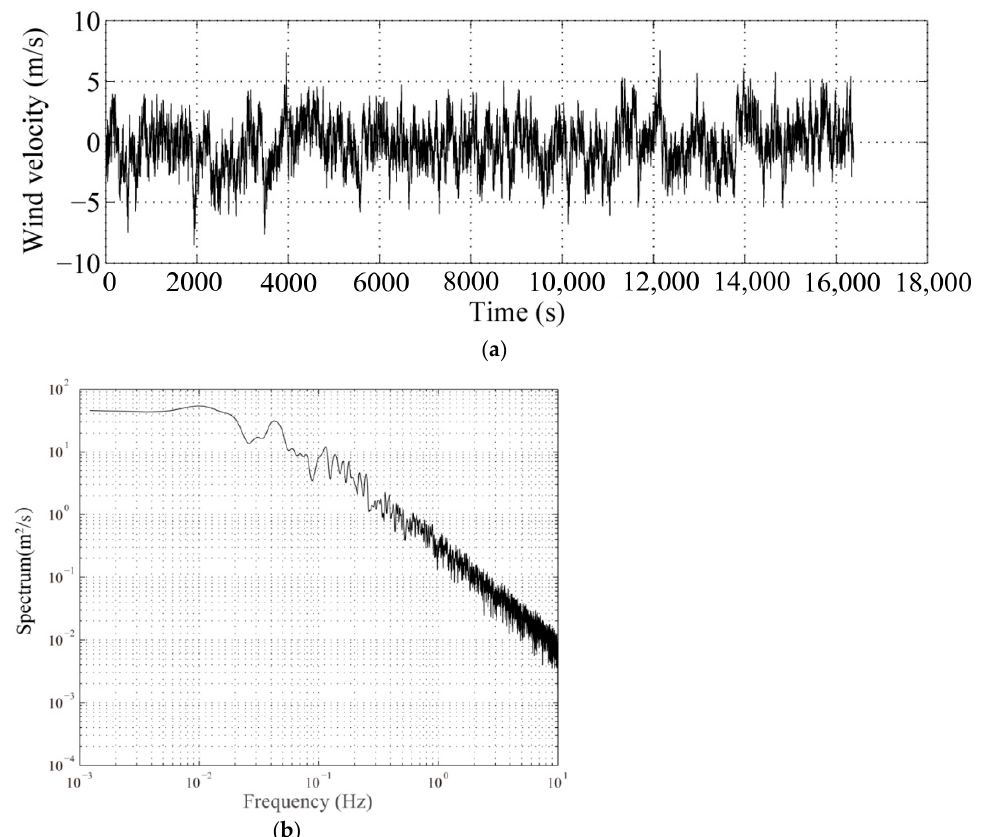
Figure 7. Simulated wind velocity and spectrum at the position of Acc 21: ( a ) wind velocity; ( b ) wind spectrum.